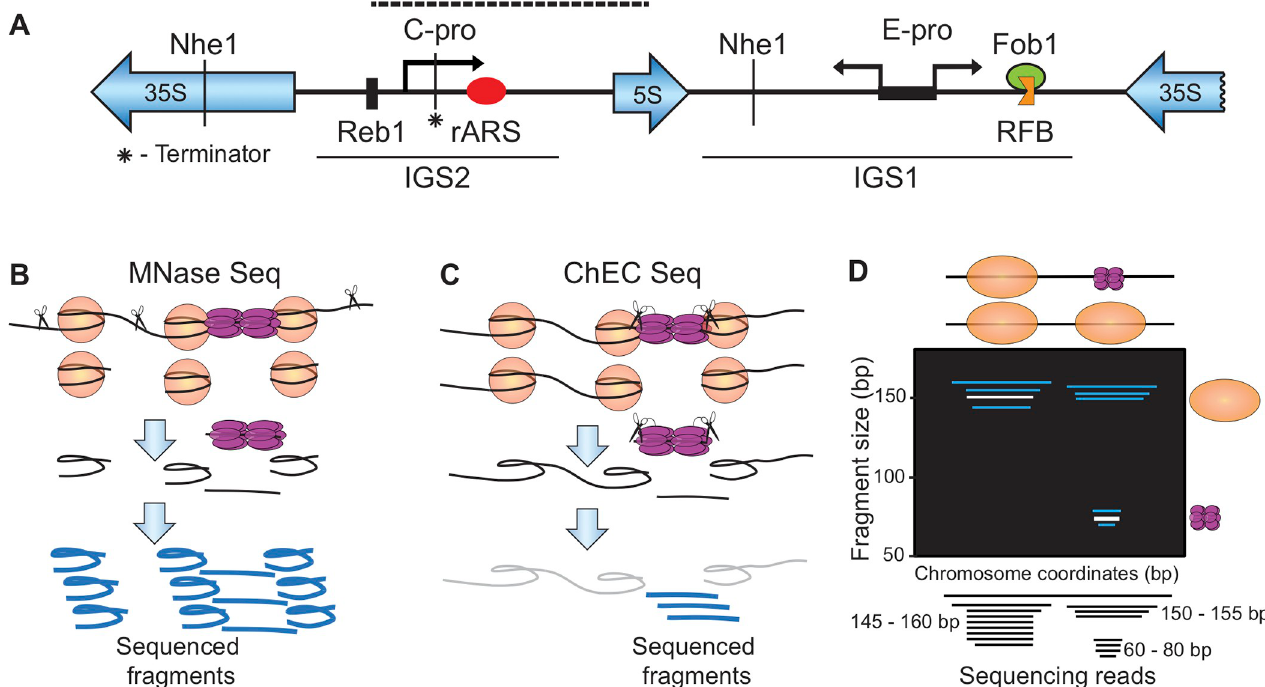
Fig 1. Ribosomal rDNA locus and sequencing-based approaches to chromatin analysis. A. Landmarks of the S . cerevisiae rDNA repeat. Each 9.1 kb repeat contains rRNA genes for the Pol I-transcribed 35S precursor RNA and the Pol III-transcribed 5S RNA, separated by two intergenic spacer regions, IGS1 and IGS2 , both of which are subject to Sir2-mediated silencing. IGS1 harbors the bidirectional Pol II promoter e-pro and the replication fork barrier (RFB), a binding site for Fob1, which enforces a unidirectional block to DNA polymerase to reduce DNA polymerase and RNA Pol I collision. IGS2 harbors c-pro, a Sir2-repressed Pol-II promoter, and rARS located 200 bp downstream from the c-pro initiation site. Additional markings include the binding site for the transcription factor Reb1 immediately upstream of c-pro, the dashed line marking the 1.25 kb fragment containing rARS analyzed in Figs 2–4, the restriction enzyme Nhe1 sites, used in 2D gels in Fig 5, and the insertion site for the terminator, used in Fig 6. B. MNase-seq enables identification of footprints of nucleosomes and other DNA binding proteins by virtue of exogenously added MNase degrading DNA that is not protected by binding of such proteins, followed by library preparation and sequencing. C. ChEC-seq involves tagging a DNA-binding protein of interest (Mcm2 shown) followed by activation of the nuclease with calcium and library preparation and sequencing. Only the MNase-cleaved fragments of interest are short enough to be PCR amplified during library preparation. Large circle presents a nucleosome, purple doublet presents Mcm2-7 and the scissors represent MNase. D. Presentation of sequencing data from MNase-seq and ChEC-seq experiments. Each mapped read is graphed according to its genomic location, on the X-axis, and its size, on the Y axis. When two particles of different sizes (e.g. a nucleosome and a replication initiation factor) occupy the same genomic region in different populations of cells, they can be distinguished by differently sized footprints that map to the same